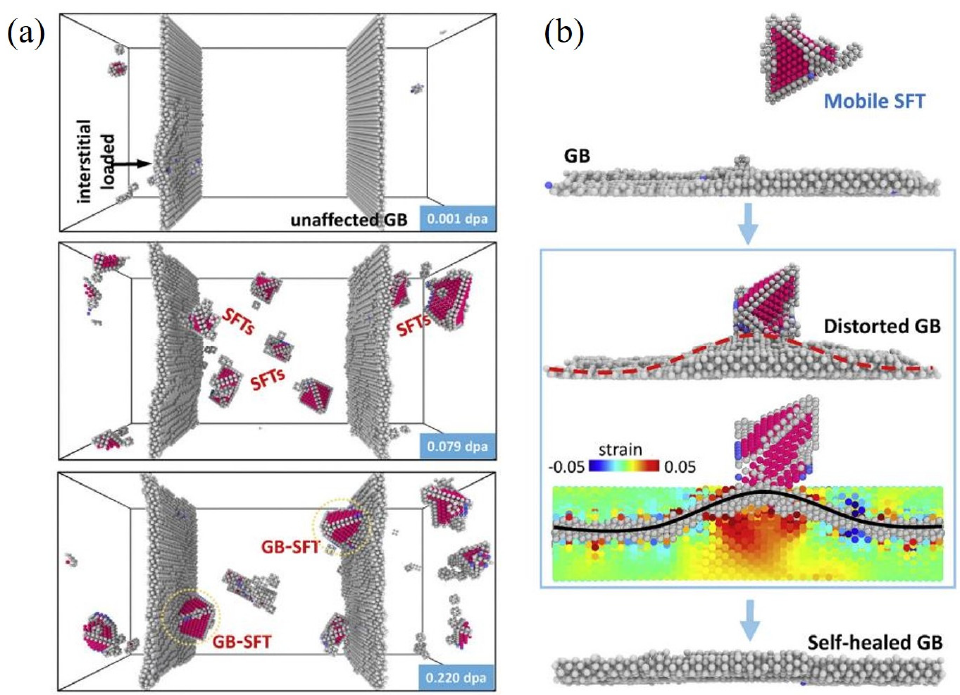
Figure 4. ( a ) Radiation-induced defect clusters and GB evolution in Σ 5(210) Cu at different doses. ( b ) SFT annihilation process via interaction with a GB. Atoms are color coded according to their structures (red—hexagonal close-packed (HCP); blue—body-centered cubic (BCC); grey—other structure, face-centered cubic (FCC); atoms not shown). Reproduced with permission from Ref. [66]. Copyright 2021 Clearance